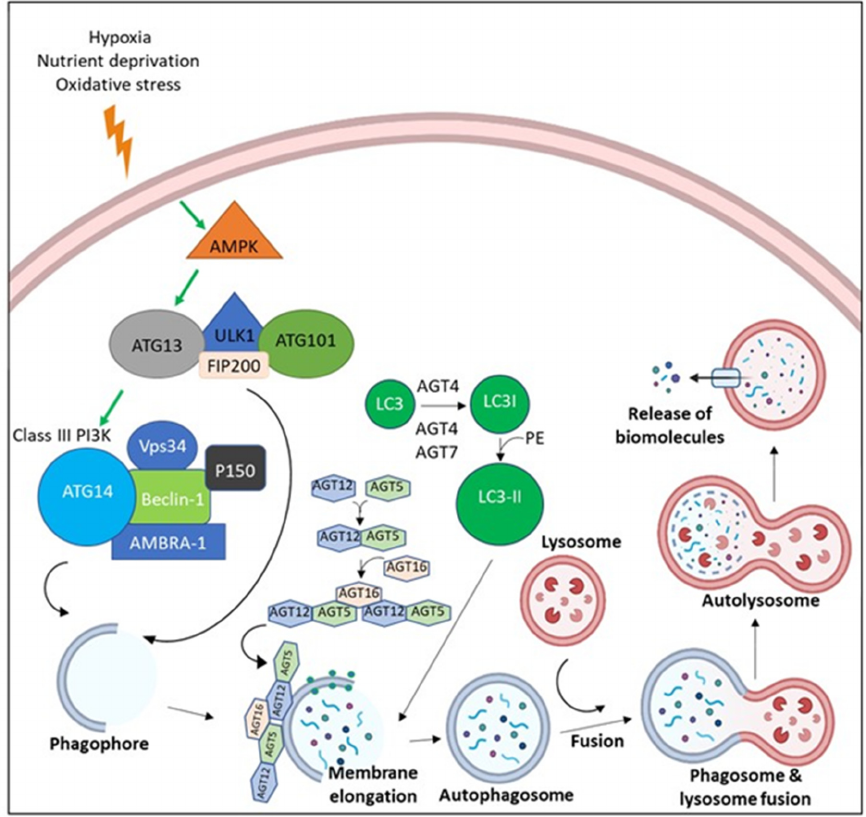
Figure 4. The molecular pathway of Autophagy. Due to the microenvironmental stress, AMP-activated protein kinase (AMPK) is activated, leading to the activation of ULK-1 complex (ULK-1, ATG13, ATG101, and FIP200). ULK-1 complex activation leads the assembly of Class III Phospho- inositide 3-kinases (PI3Ks) (Beclin-1, Vps34, AMBRA, p150, and ATG14). Both ULK-1 complex and Class III PI3K translocate to the nucleation site and stimulate the establishment of the isolation membrane known as the phagophore. Elongation of the phagophore befalls via the effect of ATG5- ATG12-ATG16 and LC3-II until a double membrane vesicle is formed, known as the autophagosome. Autophagosomes fuse with the lysosome, which leads to degradation of cargo via the effect of lysosomal enzymes with release of